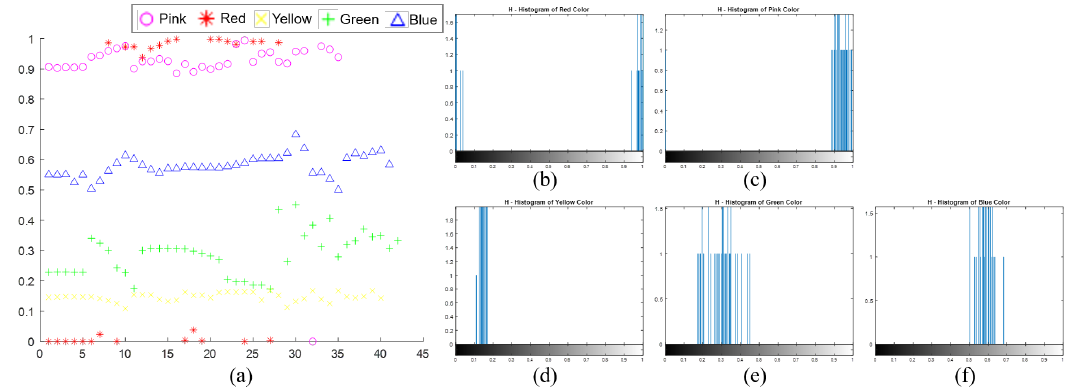
Figure 7. H value distribution about sample values: ( a ) H value distribution of all samples; ( b ) H value histogram of red color; ( c ) H value histogram of pink; ( d ) H value histogram of yellow color; ( e ) H value histogram of green color; ( f ) H value histogram of blue